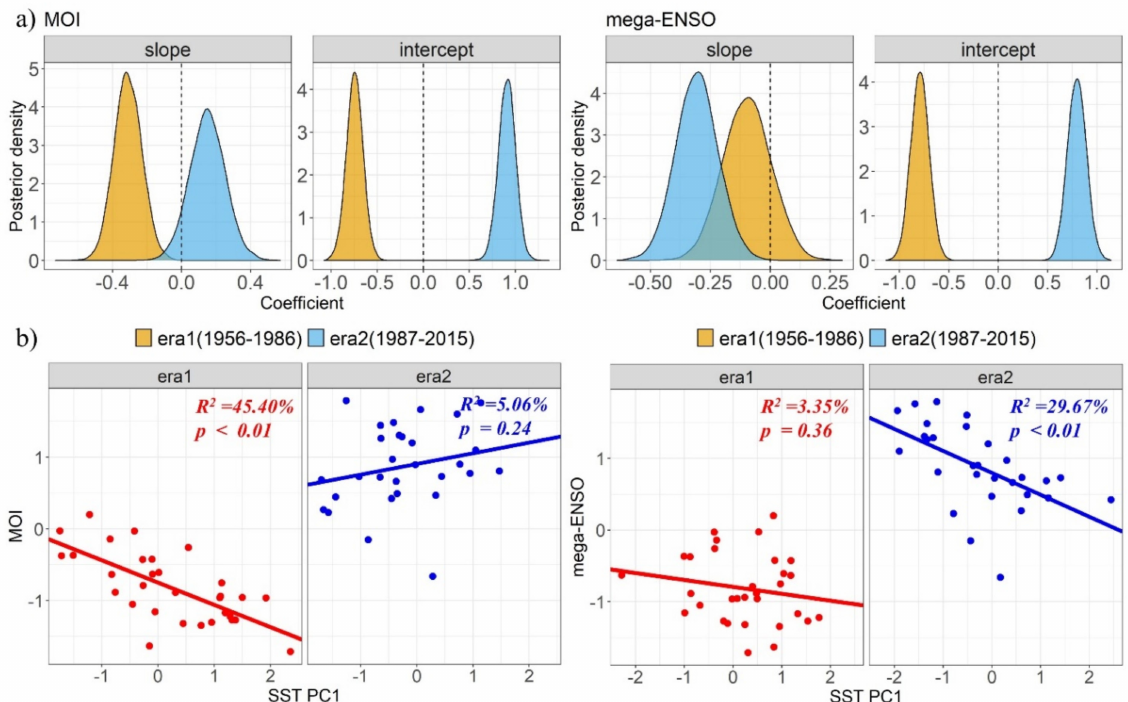
Figure 6. Nonstationary temporal relationships between MOI, mega-ENSO and SST. ( a ) Era-specific posterior distributions of the slope and intercept of the MOI and mega-ENSO on the SST PC1. ( b ) Era-specific scatter plots and best linear fittings with the corresponding R 2 and p values estimated by Bayesian regression